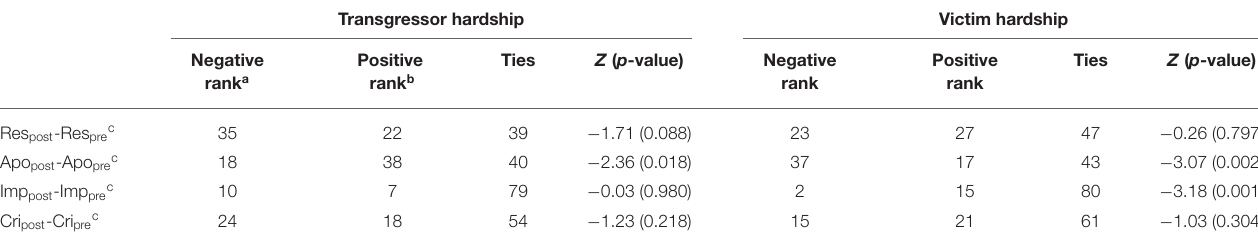
TABLE 4 | Comparisons of children’s pre- and post-preference for moral treatments. Transgressor hardship Victim hardship